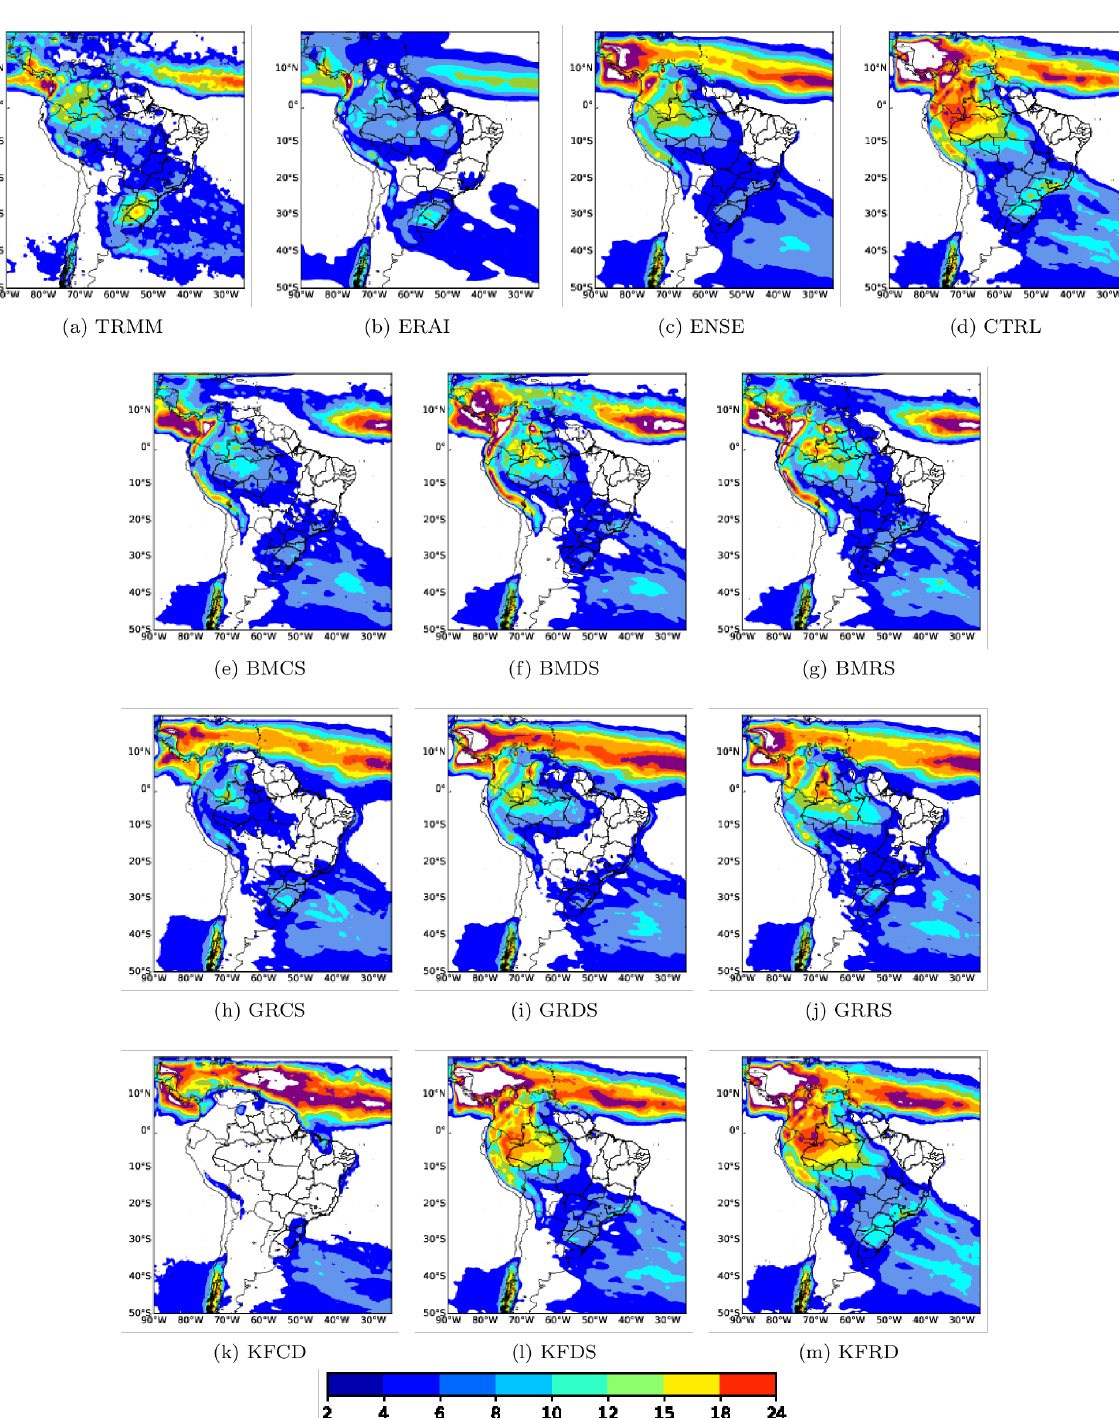
Figure 6. As in Figure 3, but for September–October–November